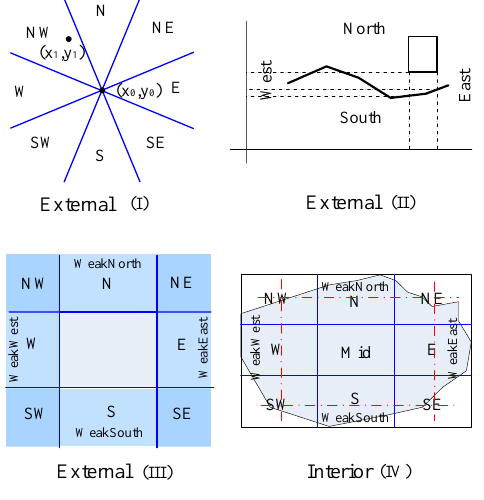
Figure 3. The main direction description models